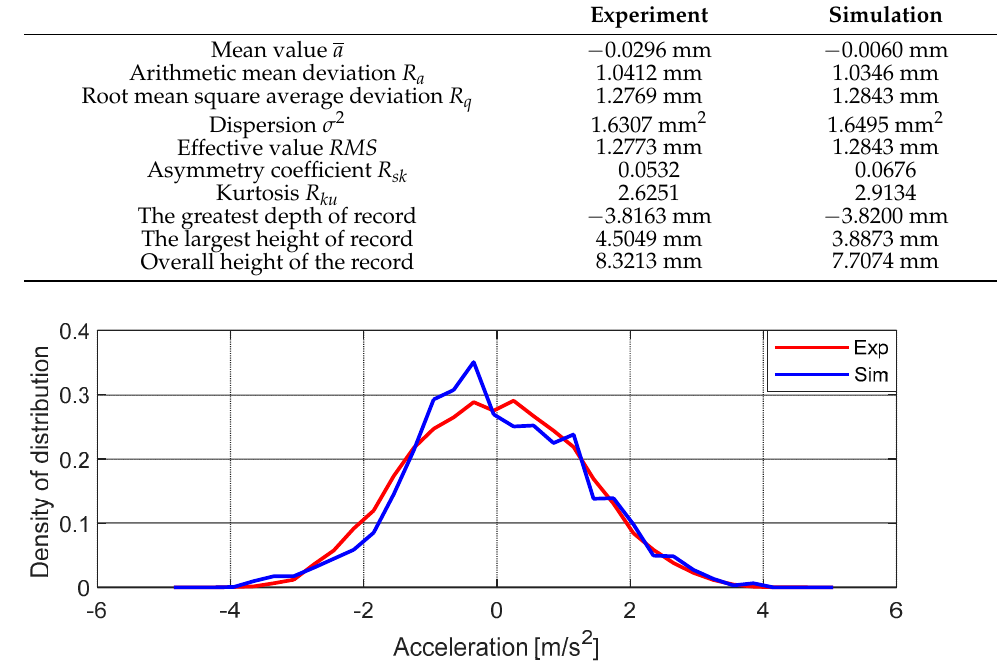
Figure 29. Density of probability distribution, acceleration in vehicle CG.